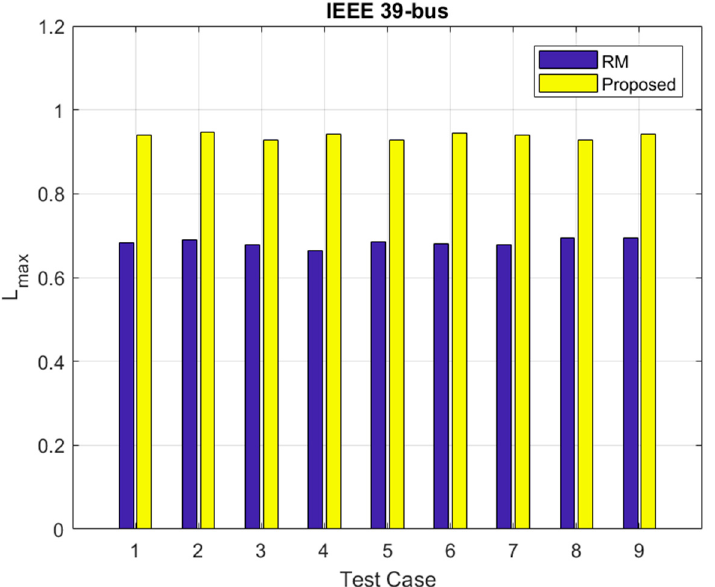
Figure 13. Comparisons for system load at voltage collapse point under different test cases in IEEE 39-bus model. A higher L max indicates a better performance.